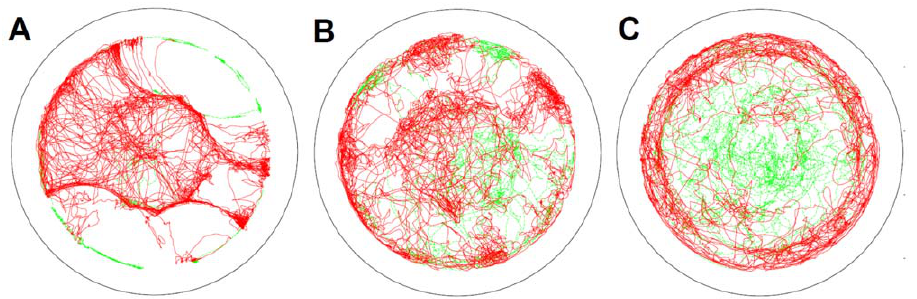
Figure 3. Typical trajectories of the center of the elements in the container. Each figure shows the circular ( A. ), square ( B. ), and triangular ( C. ) cases. The red lines show the trajectories of the active elements, and the green lines show those of the passive elements. Outer circles show the wall of the container. All the trajectories of the elements in one of the trials are overlaid in each figure.